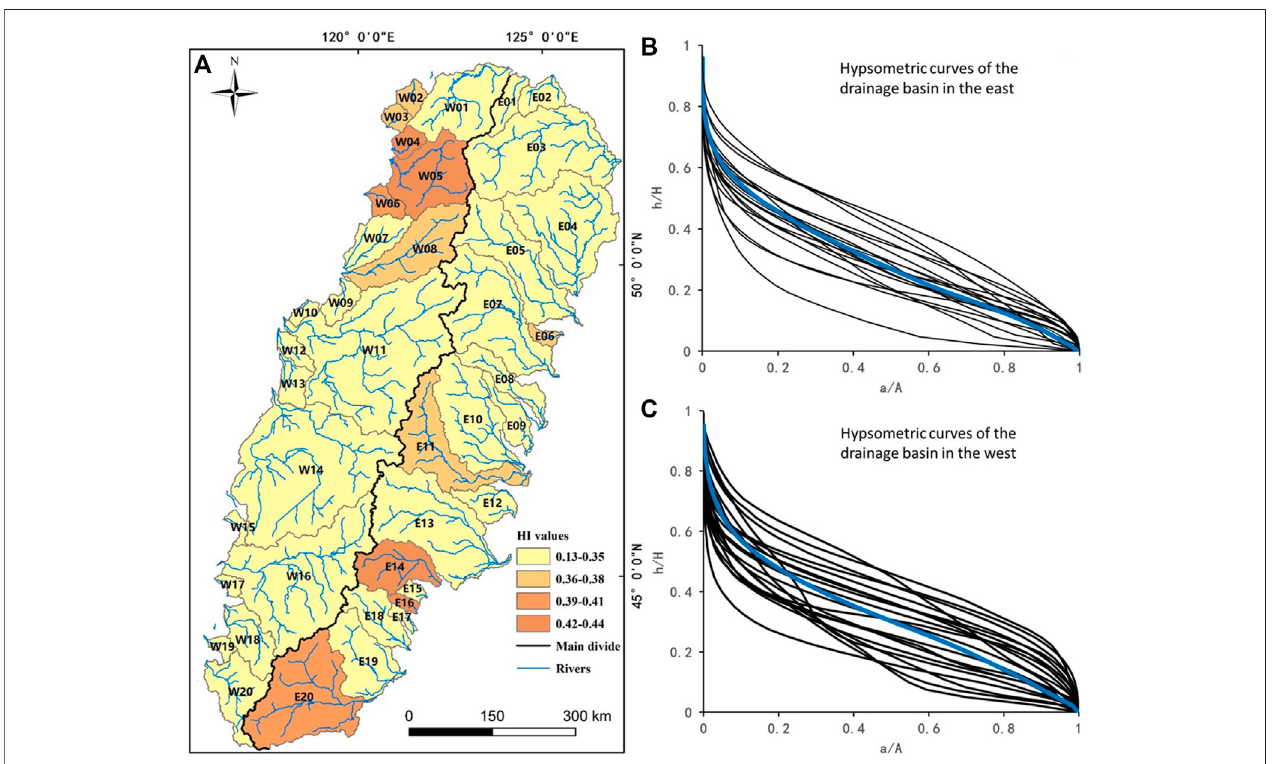
FIGURE3 | Hypsometric curves and hypsometric integral (HI) values. (A) Map-view of the HI values. (B) Hypsometric curves of 20 drainage basins in the east. (C) Hypsometric curves of 20 drainage basins in the west. Hypsometric curves and HI values were obtained using the CalHypso Tools, an ArcGIS add in developed by Pérez-Peña et al. (2009).